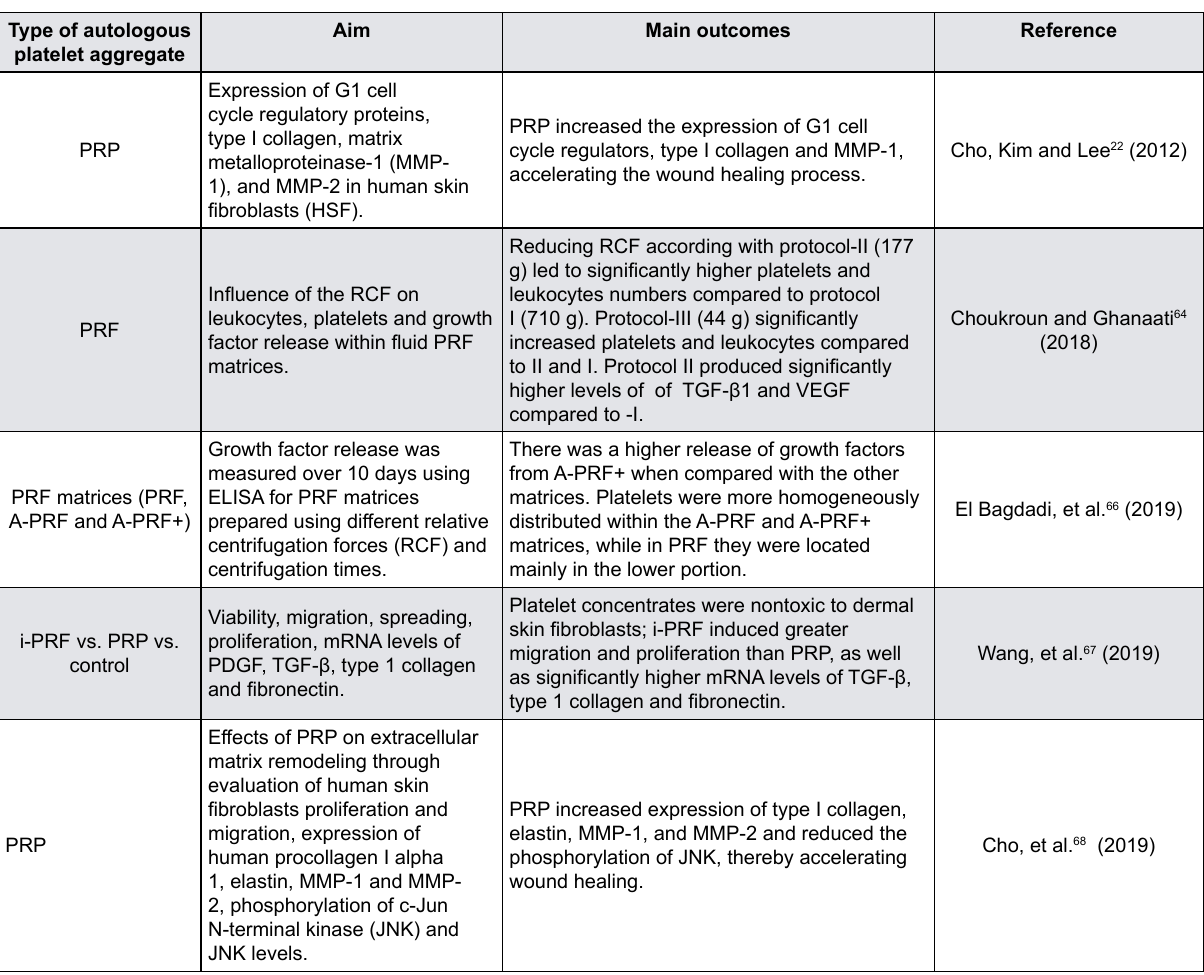
Figure 3- Laboratorial studies evaluating autologous platelet